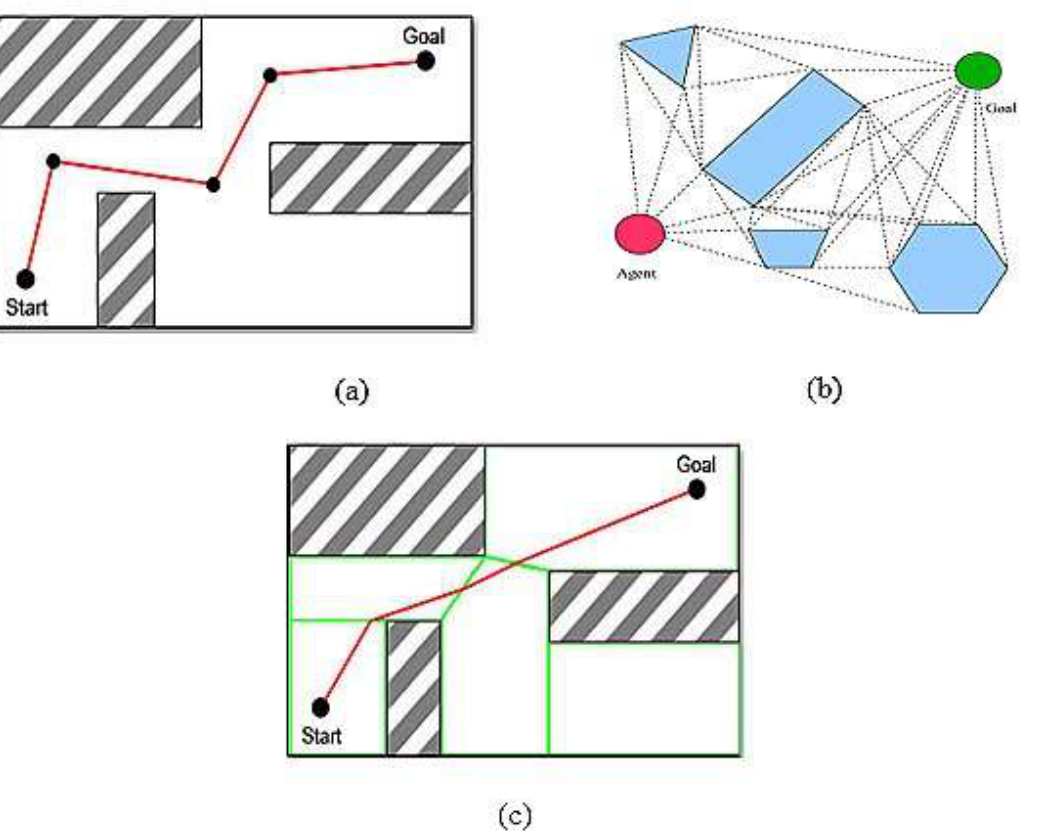
Figure 4. ( a ) Top left: waypoints, ( b ) top right: visibility graph, ( c ) bottom: navigation mesh. The different types and its categories of grid along with its smallest unit such as equi- lateral triangle, square, regular hexagon, cube, navigation marker, graph node, and edge and its applications are detailed in Table 1.